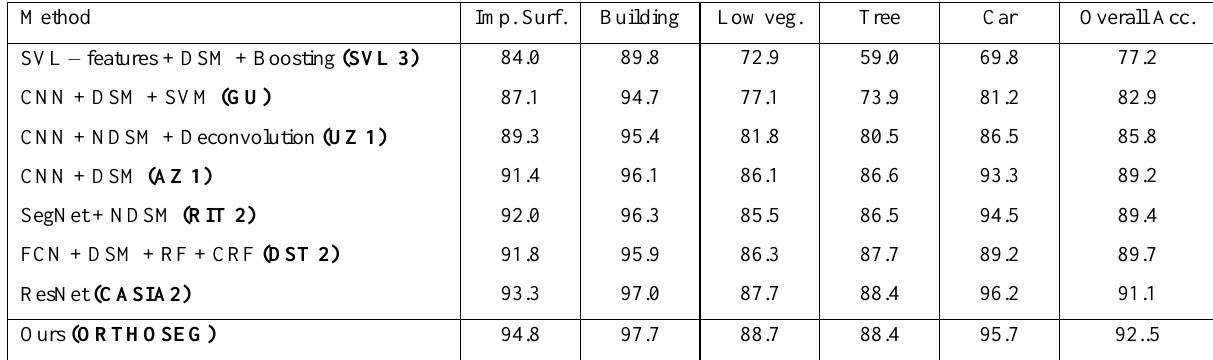
Table 3. Benchmark performance comparison. All numbers in class columns are f1 scores and overall acc. is in percentage.